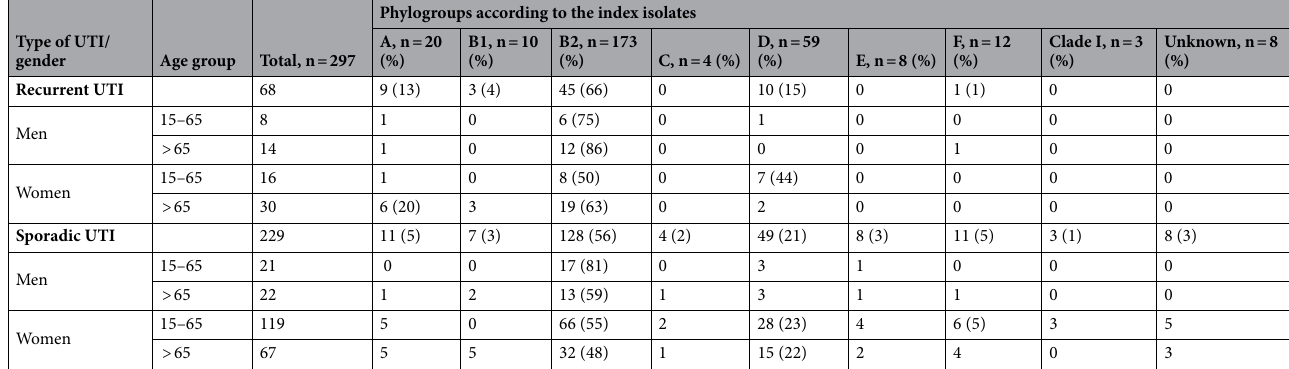
Table 2. Distribution of phylogroups in 297 ESBL- E. coli isolates in relation to recurrent and sporadic urinary tract infections (UTI) and patient